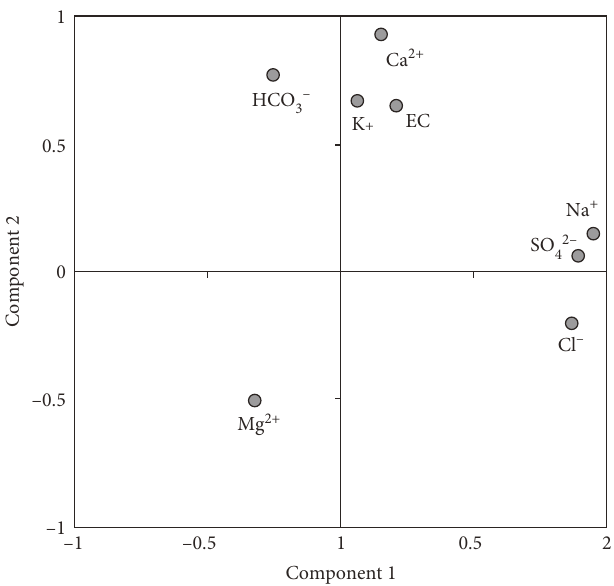
Figure 9: Factor score plot of components 1 and 2 in rotated space of the main analysed